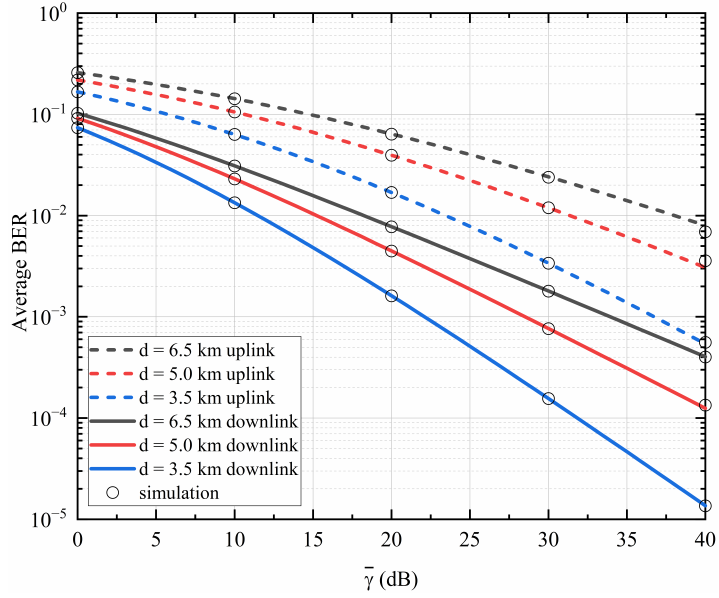
Figure 9. Average BER under different FSO communication distance when ξ = 10, L = 32, N = 10.